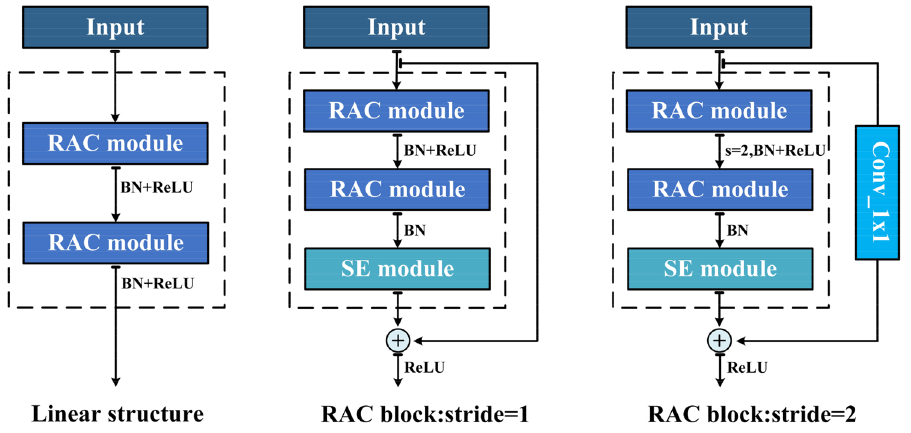
Figure 4. The illustration of RAC block.